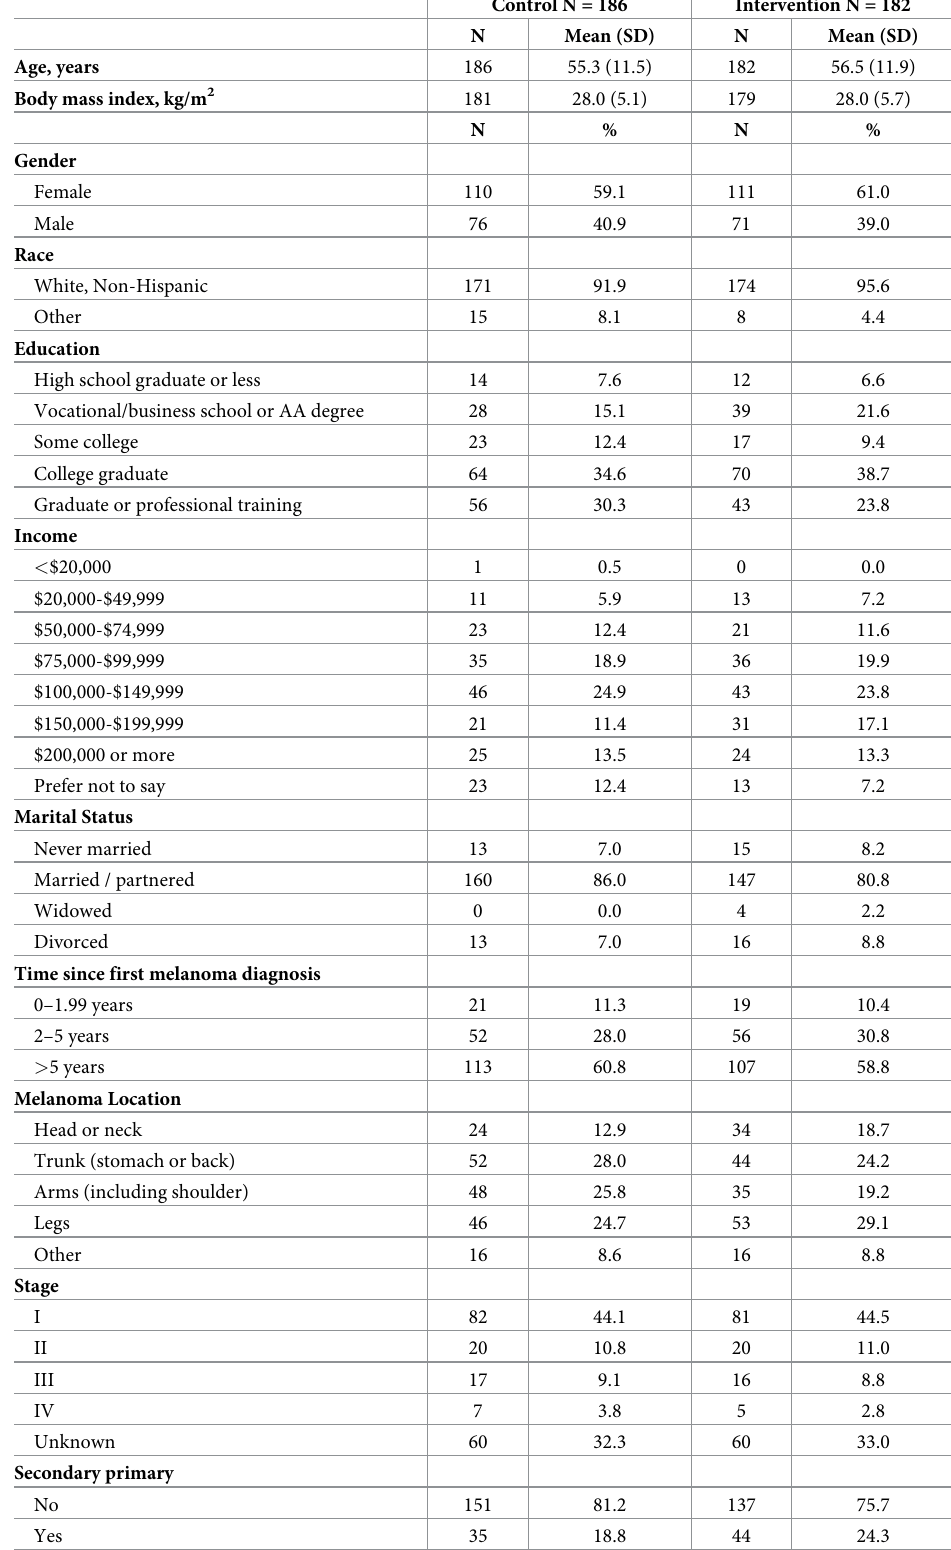
Table 1. Baseline demographics of the intervention and control participants (N =